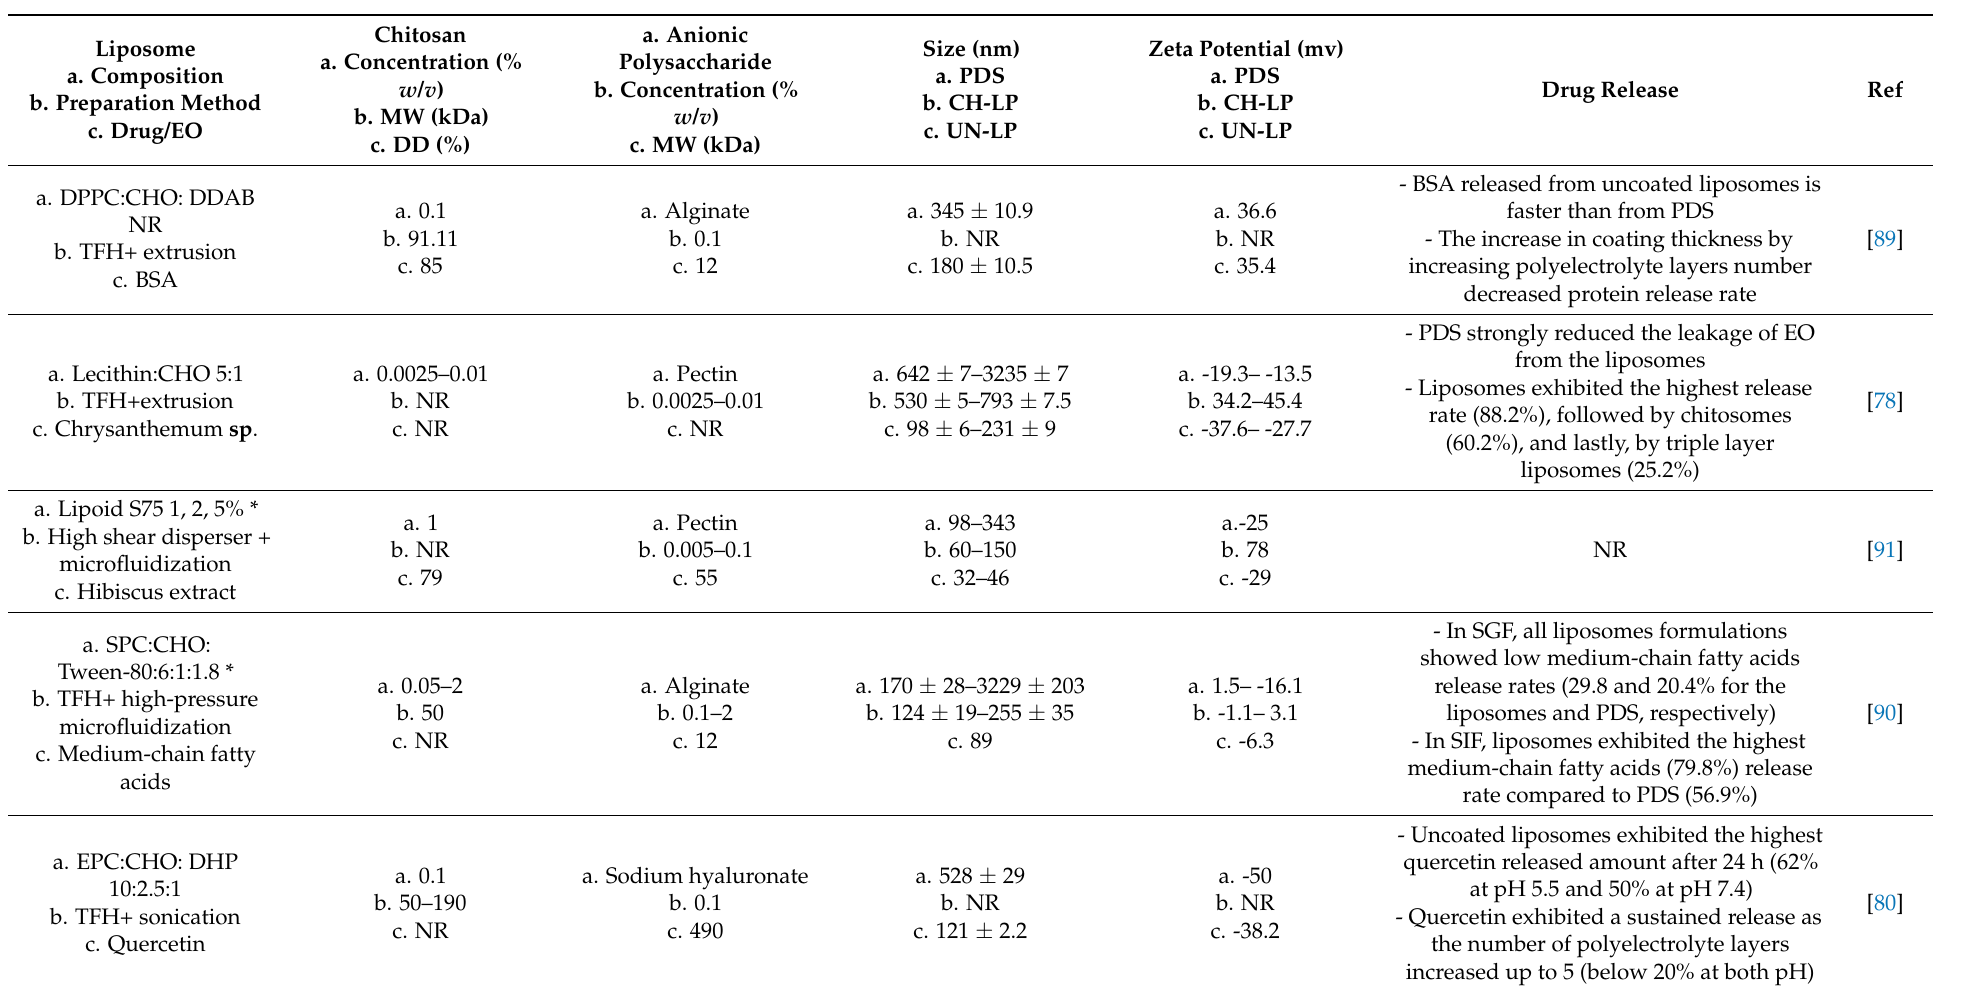
Table 13. Comparison of size, zeta potential, stability and drug release between polyelectrolyte delivery system (PDS), chitosomes and conventional liposomes. The liposomal composition is indicated in the table in molar ratio except when * exists, indicating a weight ratio ( w/w